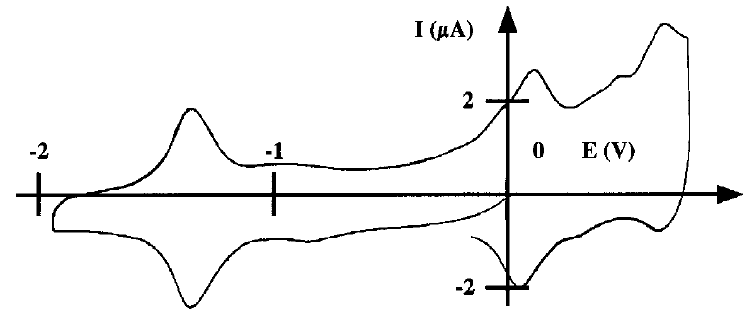
Figure 2 : Cyclic voltammogram of a carbon electrode coated by a poly 2 film (1 nmolcm -2 ) in CH 3 CN + 0.1 M TBAP. Scan rate: 20 mVs -1